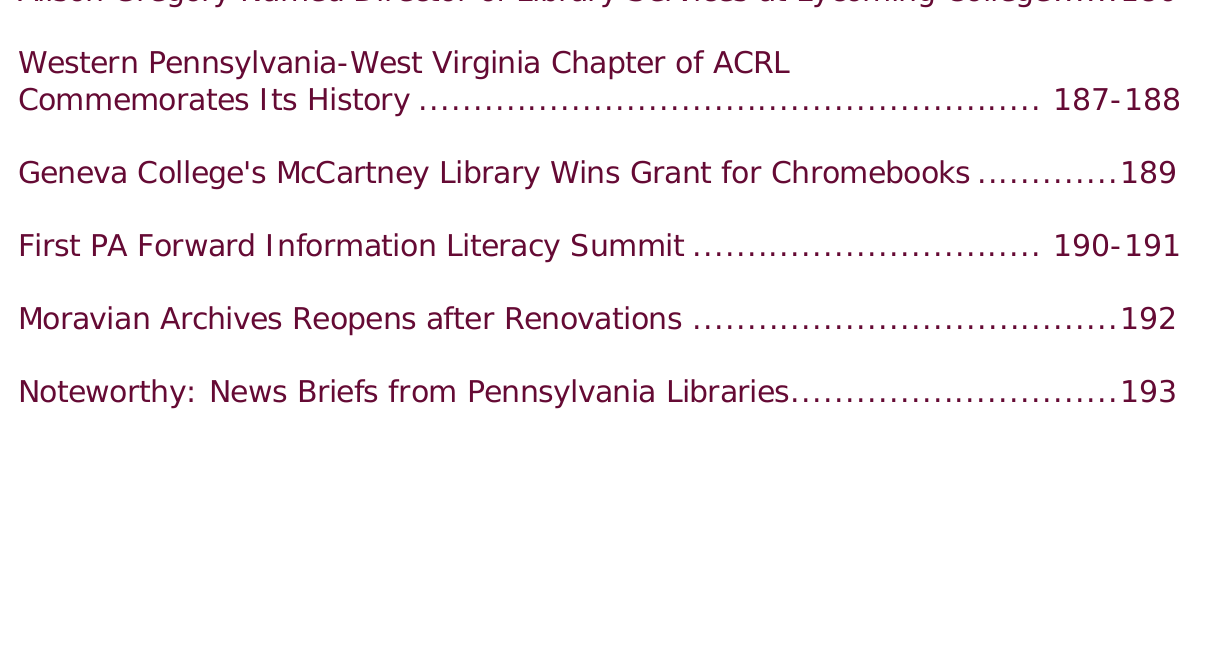
Vol. 1, No. 2 (Fall